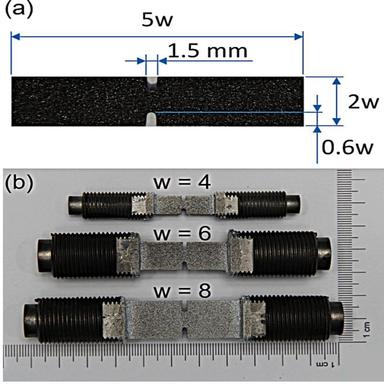
Images of Double-edge notched tension (DENT) specimens: (a) geometry for the gauge section of the intralaminar fracture toughness DENT specimens; (b) three sizes of speckled DENT specimens in the threaded grips for intermediate strain rate testing.